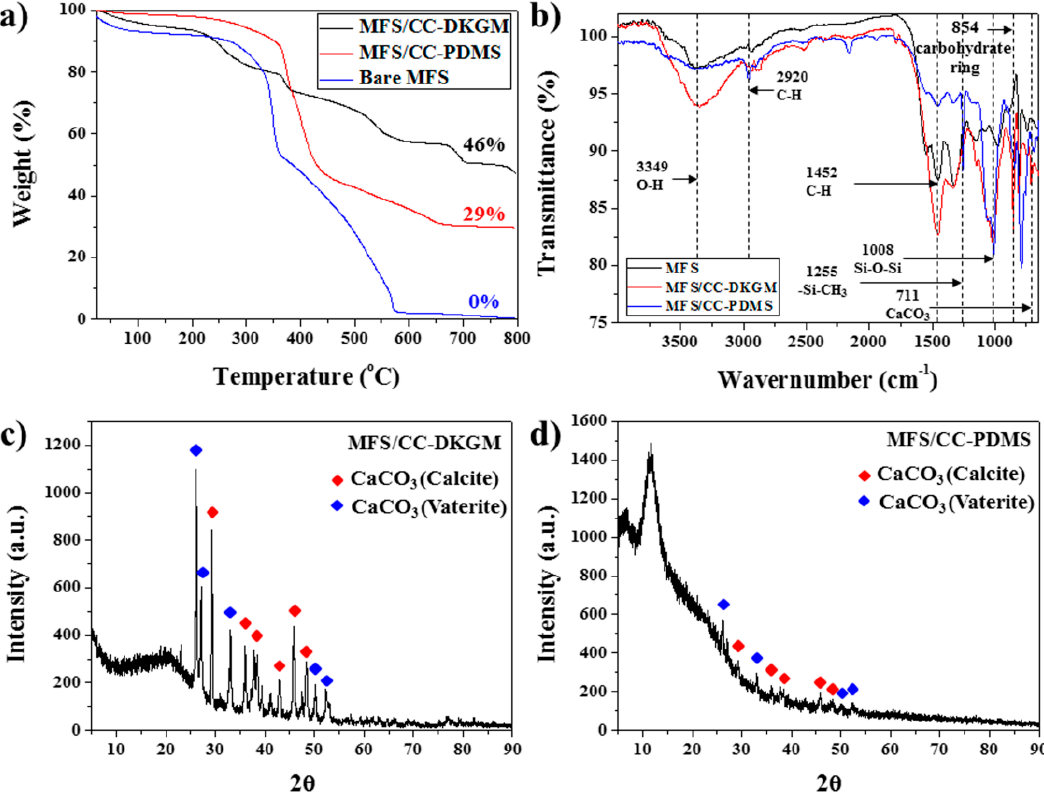
Figure 3. ( a ) TGA data for the (black line) MFS/CC-DKGM and (red line) MFS/CC-PDMS. ( b ) FT-IR data for the (black line) MFS, (red line) MFS/CC-DKGM, and (blue line) MFS/CC-PDMS. XRD data for the ( c ) MFS/CC-DKGM and ( d ) MFS/CC-PDMS.